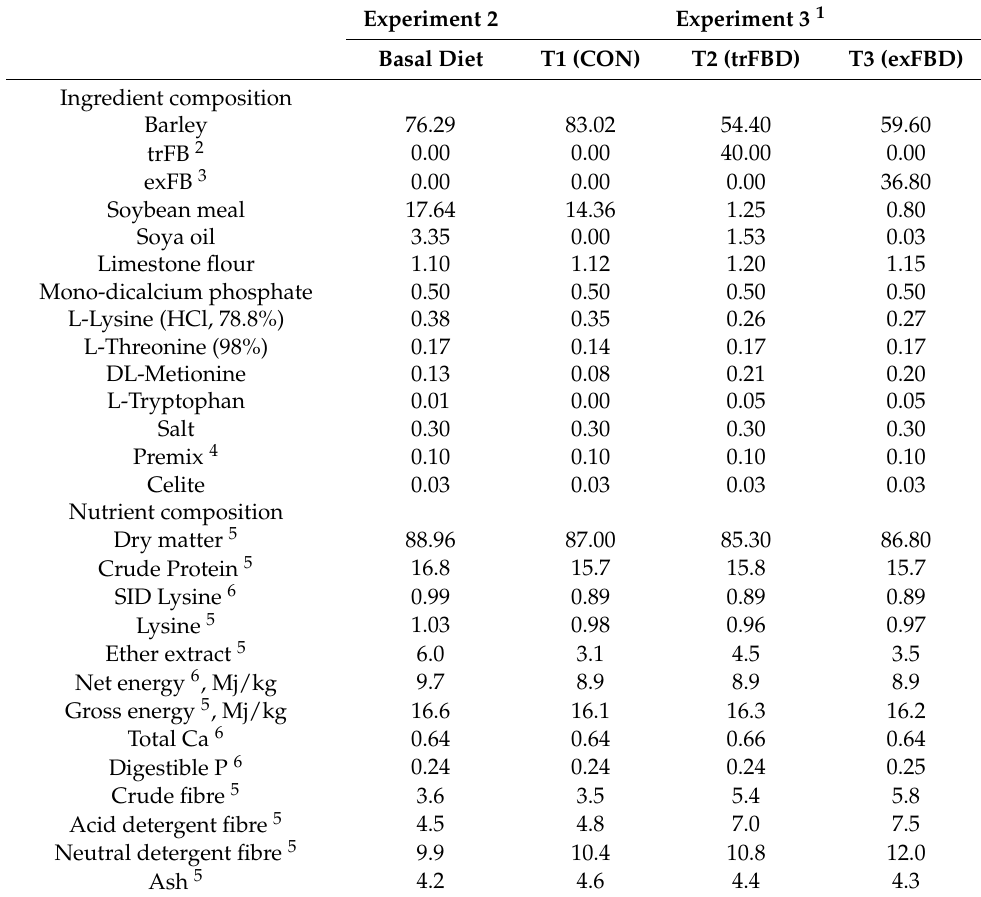
Table 2. Ingredient and nutrient composition of dietary treatments of experiments 2 and 3 (in %, on as fed basis; unless otherwise